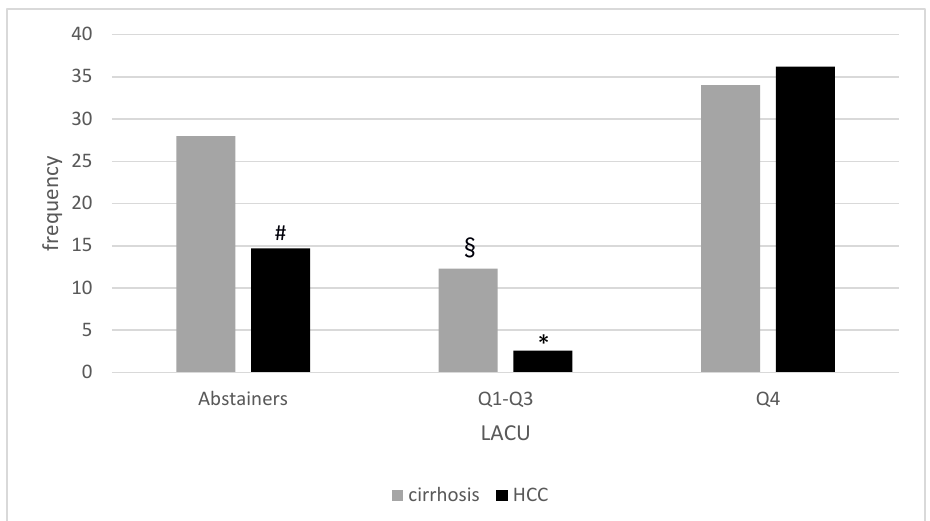
Figure 2. Prevalence of cirrhosis and HCC according to lifetime alcohol consumption (LACU). § p < 0.01 compared to lifetime abstainers and p < 0.001 compared to Q4; * p < 0.001 compared to both lifetime abstainers and Q4 ; # p < 0.01 compared to Q4.